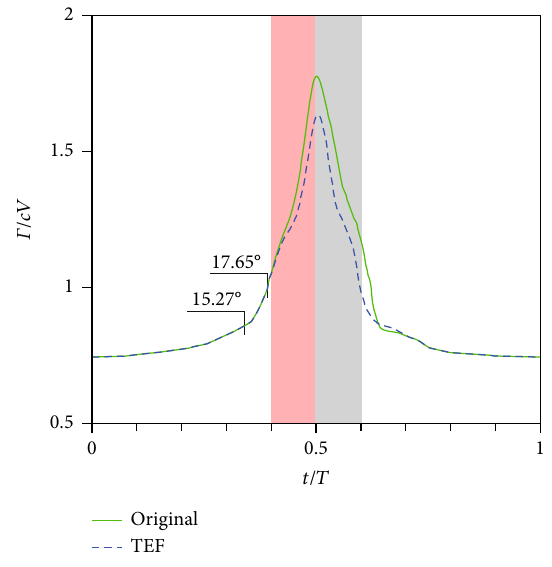
Figure 17: Comparison of the normalized circulation in the planar control region during one pitching cycle for the two di ff erent airfoils. The pink region represents that the TEF de fl ects upwards. The gray region represents that the TEF de fl ects